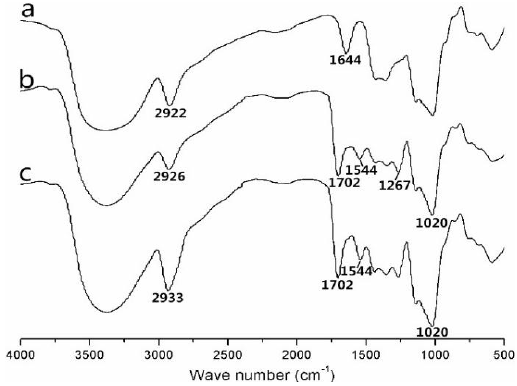
Figure 2. Infrared spectra of pullulan ( a ); amino-pullulan ( b ); and CHAP( c ).